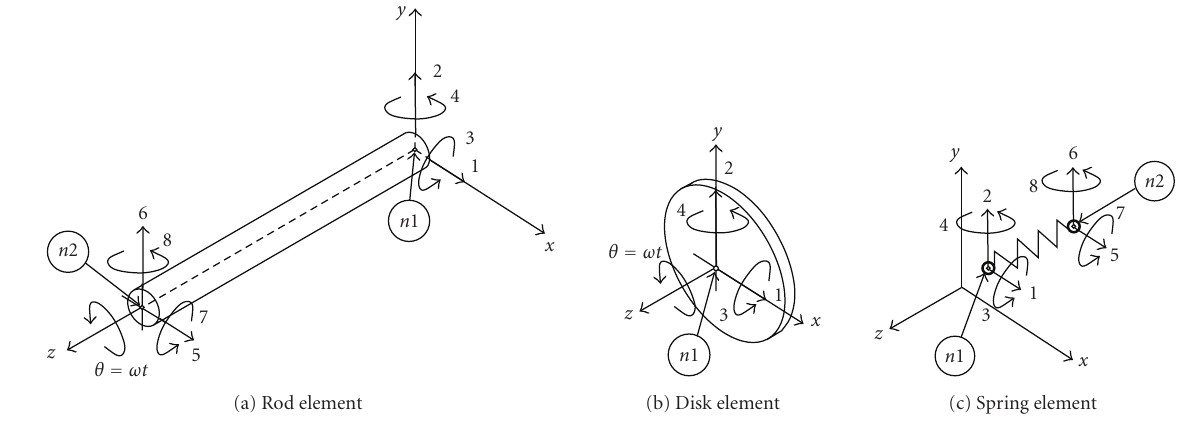
Figure 5: Finite elements